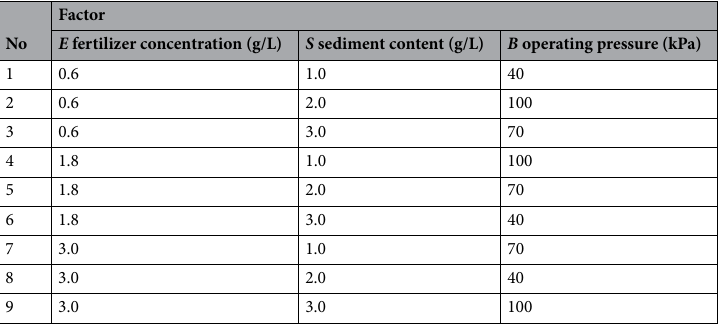
Table 2. UL 9 (3 3 ) uniform orthogonal test